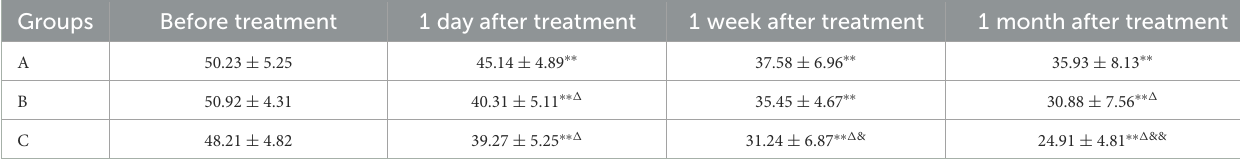
TABLE 4 SAS scores of patients before and after treatment (mean ± SD).